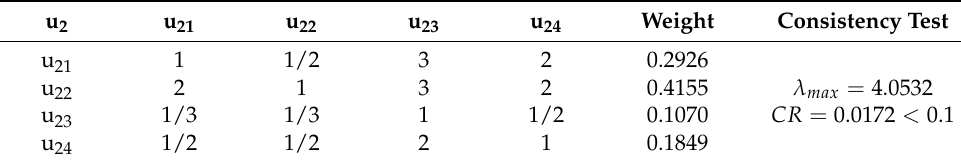
Table 9. The judgment matrix and weights of evaluation indicators under u 2 .